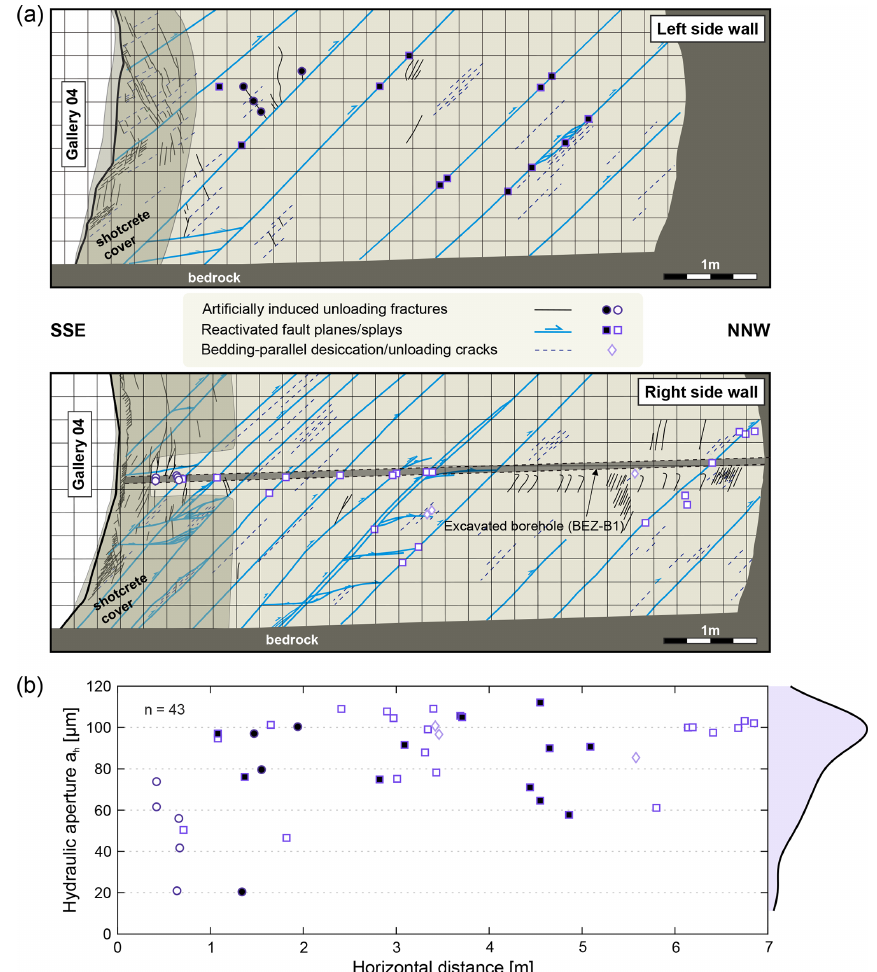
Figure 3. (a) Structural maps of the EZ-B niche with measurement points for hydraulic and mechanical aperture determination on the left (closed symbols) and right side wall (open symbols), modified after Nussbaum et al. (2005). (b) Hydraulic fracture apertures measured by the air permeameter plotted against the distance to Gallery 04. On the right side, the distribution of a h is visualized by a probability density function obtained by kernel density estimation